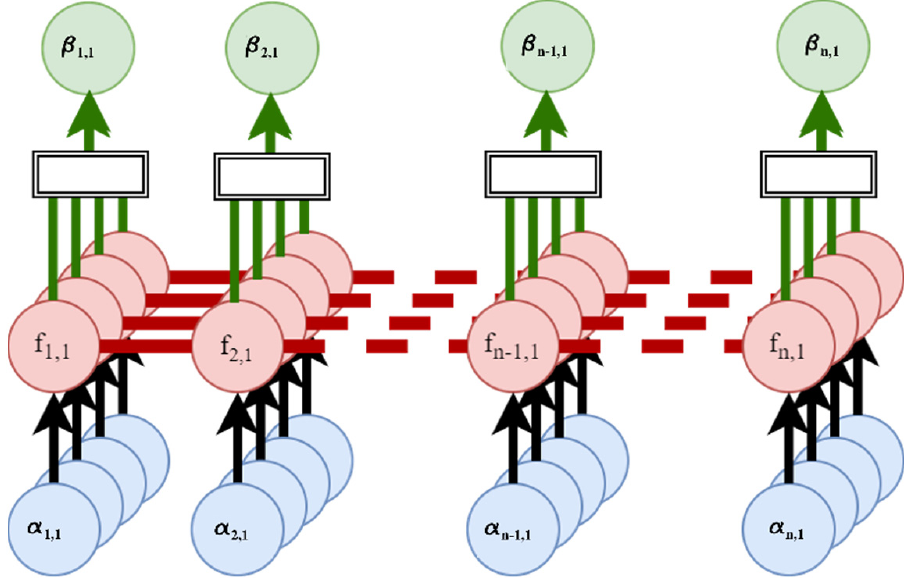
Figure 5. Exponential Gaussian Process Regression model used to predict ankle, knee, hip, and L5S1 angles.